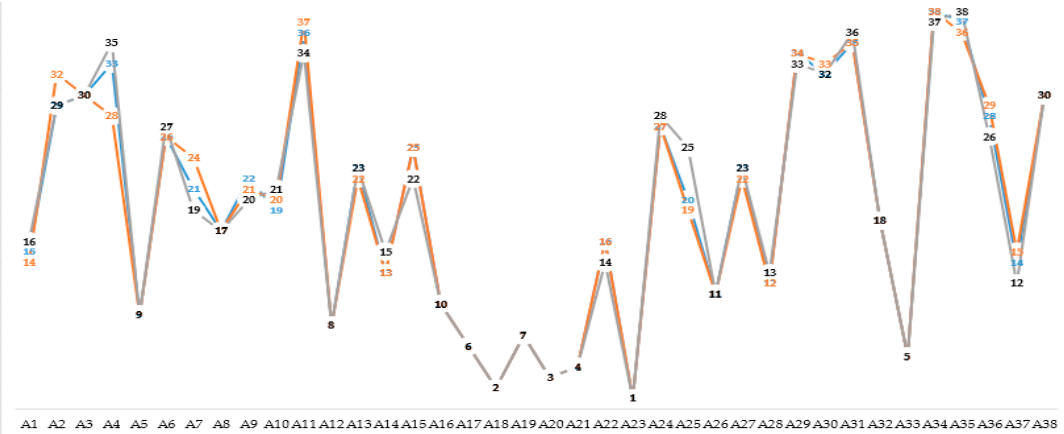
Figure 6. Results of comparison with Fuzzy SAW and fuzzy TOPSIS methods.